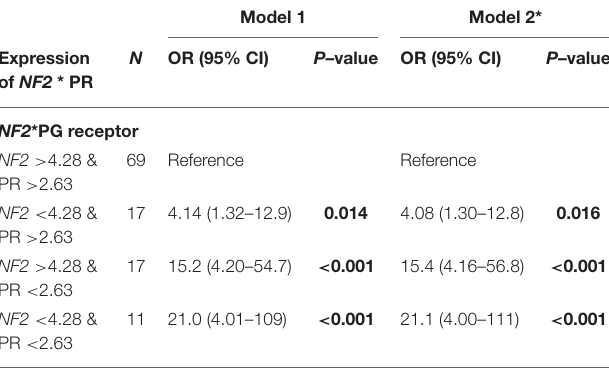
TABLE 4 | Interactions between PR and NF2